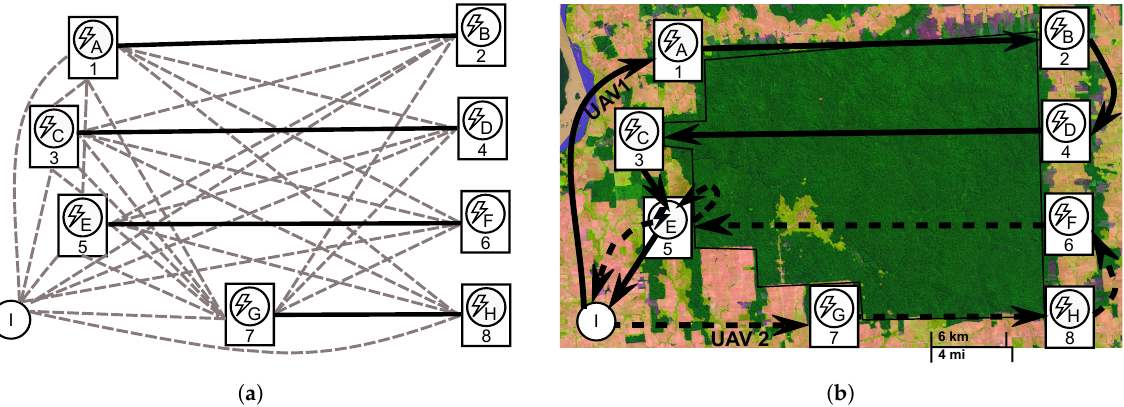
Figure 1. Example of the graph used to represent a coverage area and the solution illustrated in a preservation area image. ( a ) The recharging stations that can be opened in the area are represented by A–H, the depot is the vertex (I), and the targets are identified by the numbers 1–8. ( b ) An illustration of coverage routes applied to preservation area monitoring. Deforestation map of the Amazon from the TerraBrasilis website